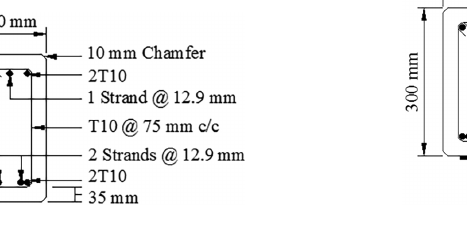
Figure 1. Specimen reinforcement